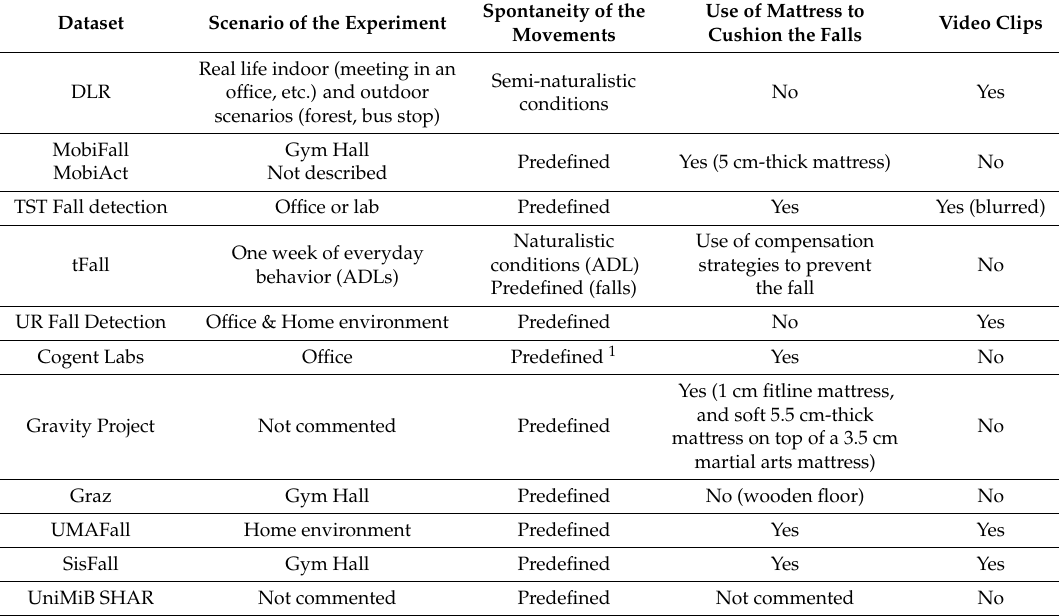
Table 4. Environment of the testbed and spontaneity of the